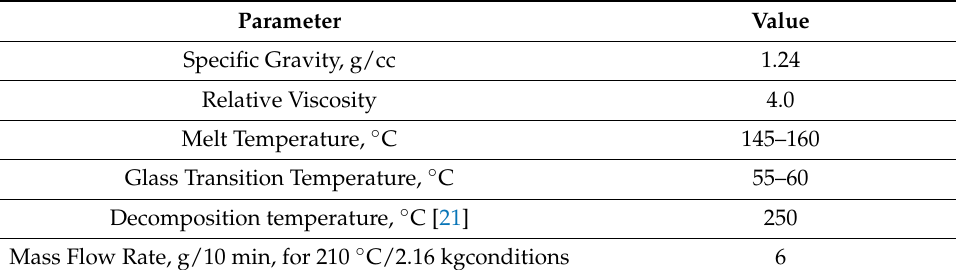
Table 1. Physical properties for Ingeo™ Biopolymer 4043D